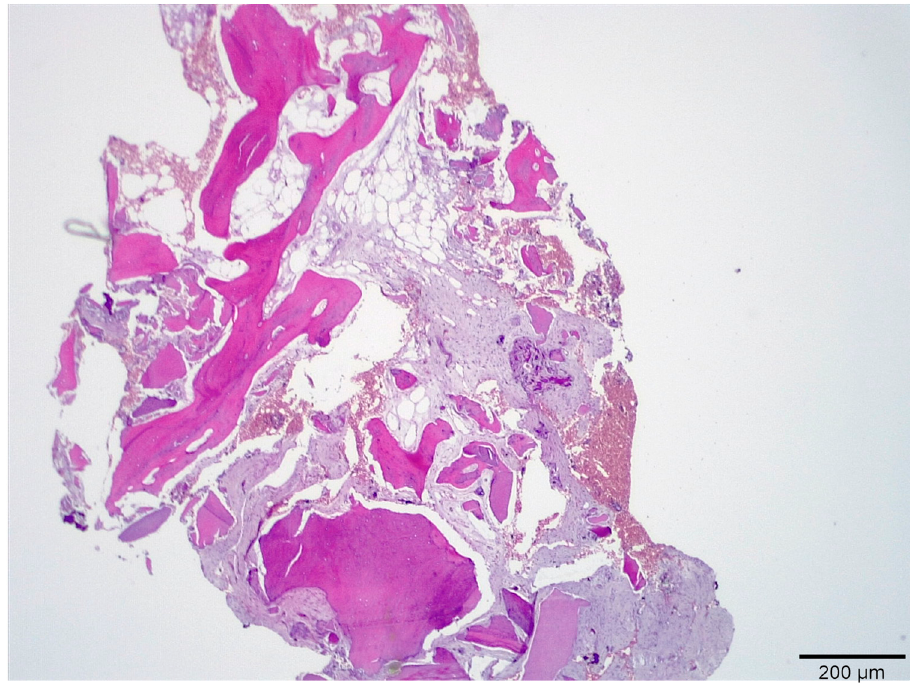
Figure 5. Sample image at six months of evaluation, in which we can see small particles of dentin integrated in the bone.